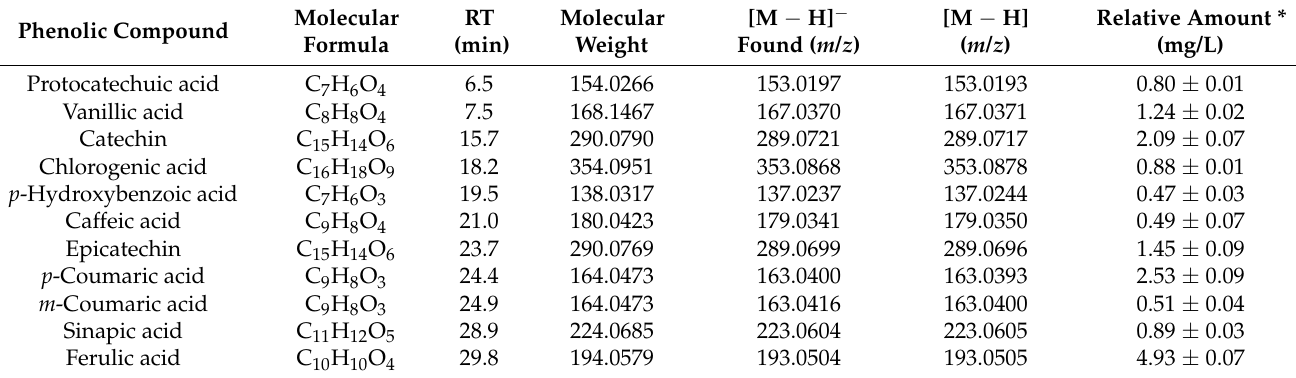
Table 2. High Resolution Mass Spectrometry HPLC data of tentatively identified phenolic compounds in D-Aliophen ® . Phenolic